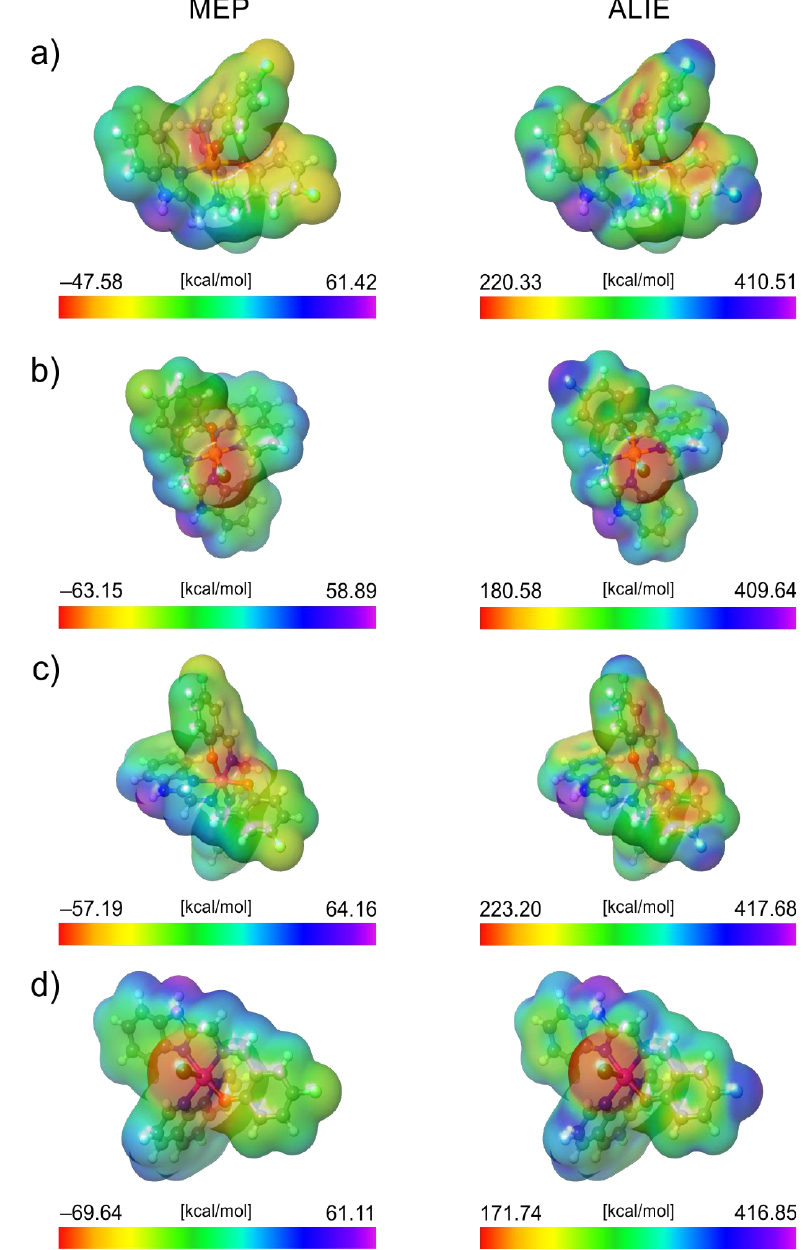
Figure 10. ( a – d ) MEP and ALIE values of studied complexes. Presented surfaces have been obtained taking the isovalue of ±0.001 a.u.